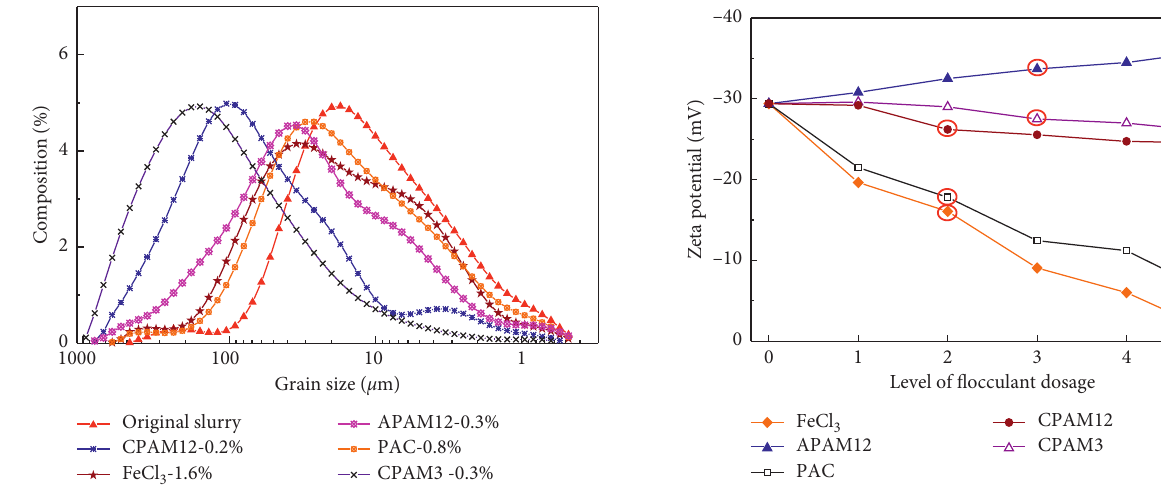
Figure 8: Aggregate frequency distribution of slurry without flocculant and with different flocculants.